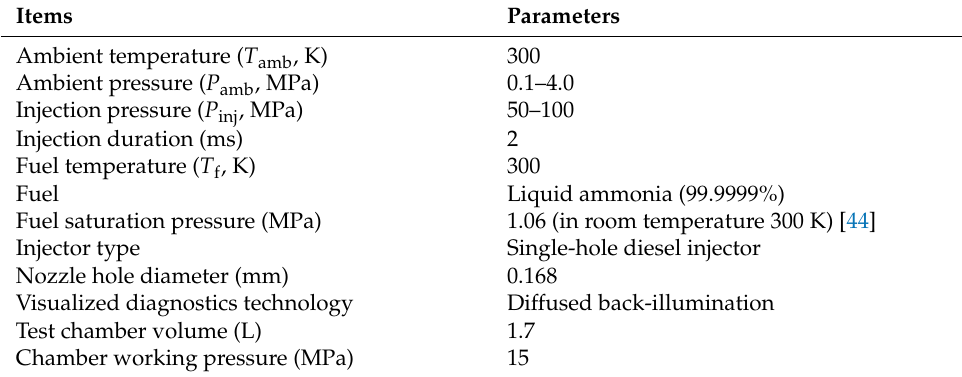
Figure 1. Schematic of the experimental apparatus. Table 1. Key parameters of experimental conditions.